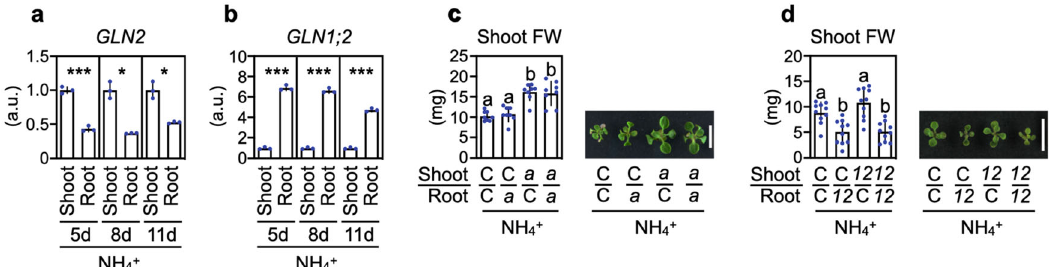
Fig. 3 Shoot GLN2 causes ammonium toxicity, whilst root GLN1;2 attenuates it. a Relative transcript levels of GLN2 in the shoots and roots of 5-, 8-, or 11- d-old Col grown on media containing 10 mM ammonium (mean ± SD; n = 3). b Relative transcript levels of GLN1;2 in the shoots and roots of 5-, 8-, or 11-d- old Col grown on media containing 10 mM ammonium (mean ± SD; n = 3). a , b Twelve shoots and roots from one plate constituted a single biological replicate. * P < 0.05; ** P < 0.01; *** P < 0.001 (Welch ’ s t -test). c FW of shoots from 17-d-old reciprocally grafted plants between Col (C) and ami2 ( a ) 7 d after transfer to media containing 10 mM ammonium (mean ± SD; n = 8). d FW of shoots from 17-d-old reciprocally grafted plants between Col (C) and gln1;2-1 7 d after transfer to media containing 10 mM ammonium (mean ± SD; n = 10). c , d One shoot from one plate constituted a single biological replicate. Different letters denote signi fi cant differences at P < 0.05 (Tukey – Kramer ’ s multiple comparison test). Representative photograph of 17-d-old shoots 7 d after transfer to media containing 10 mM ammonium are shown. The scale bar represents 10